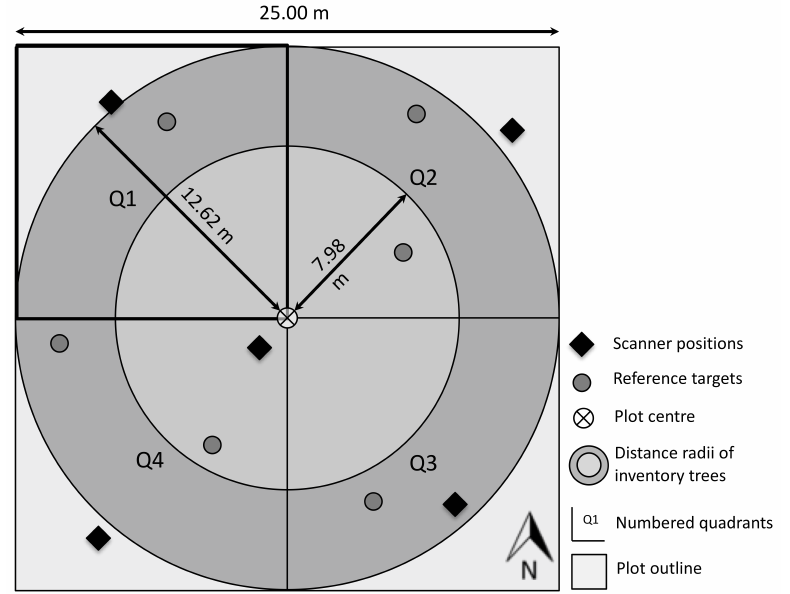
Figure 1. Schema of the sample plot setup for scanning and reference data. The square shape of the sample plot was centred on the inventory point. Five TLS positions were oriented towards the corners and the centre and six reference targets were distributed over the plot area. The two concentric circles indicate the distance radii at which trees of different DBH are measured by the NFI. The plot was subdivided into four quadrants (Q1–Q4). For each quadrant ground cover of the regeneration was estimated in the